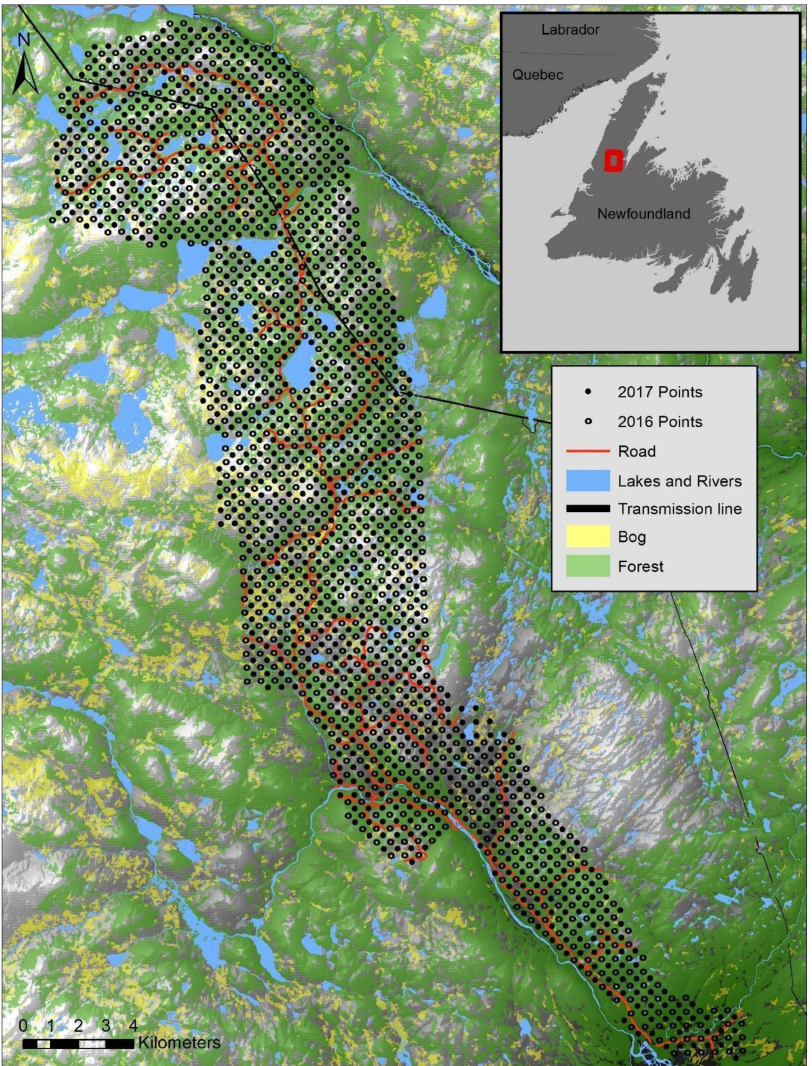
Figure 1. Distribution of survey points in the Main River and upper Humber River watersheds in western Newfoundland, Canada. Each year, points in the survey grid were spaced 500 m apart, and in 2017 the grid was shifted 250 m north and 250 m east, placing the points midway between those sampled the previous year. The location of the study area on the island of Newfoundland is shown by the red box on the inset